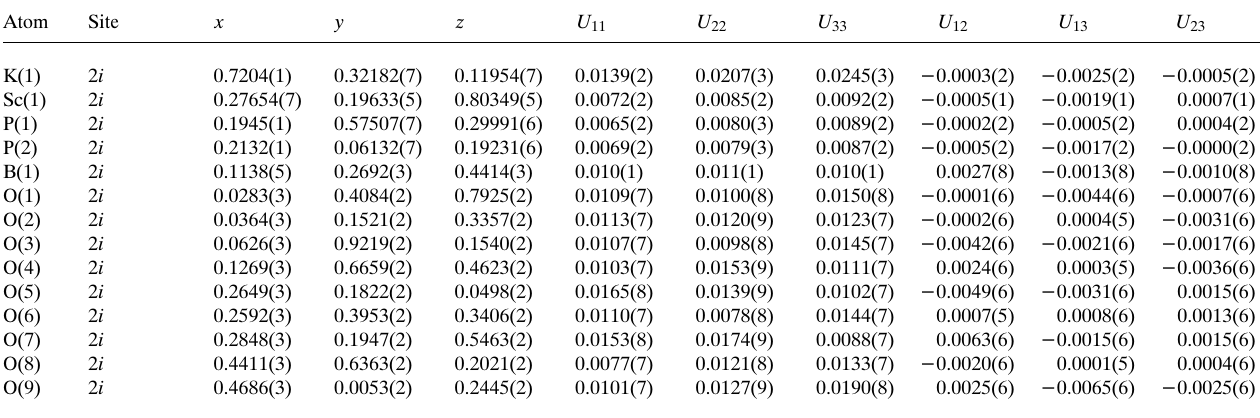
Table 3. Atomic coordinates and displacement parameters (in Å 2 )